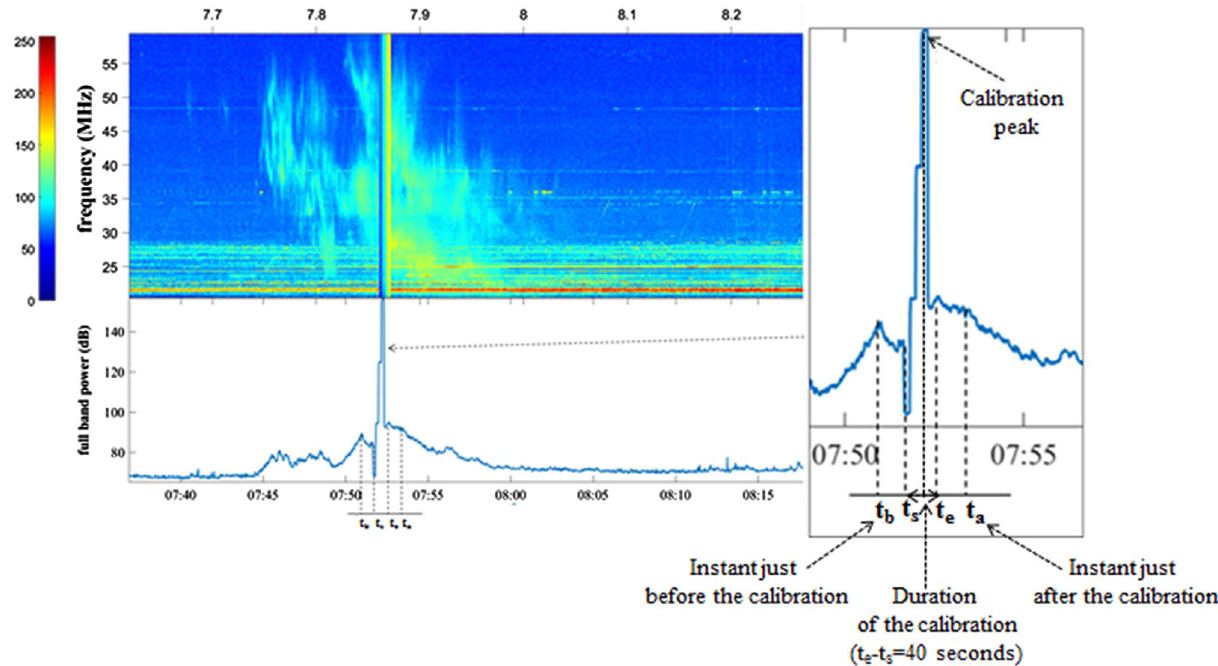
Fig. A.2. Pattern of a calibration signal.